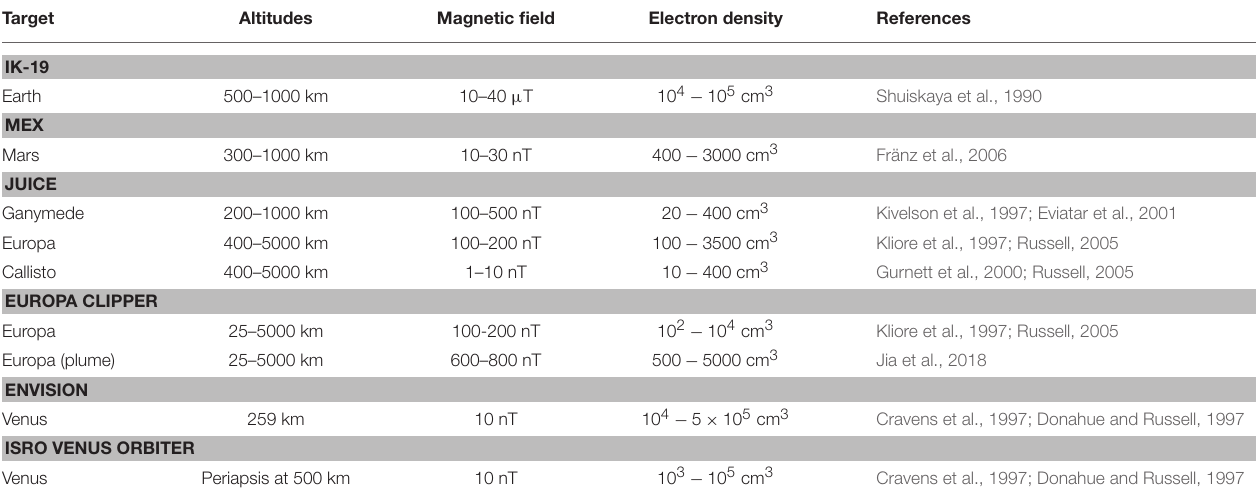
TABLE 3 | Local plasma characteristics (density and magnetic field) typical for SAP observations in the ionospheres of Earth and